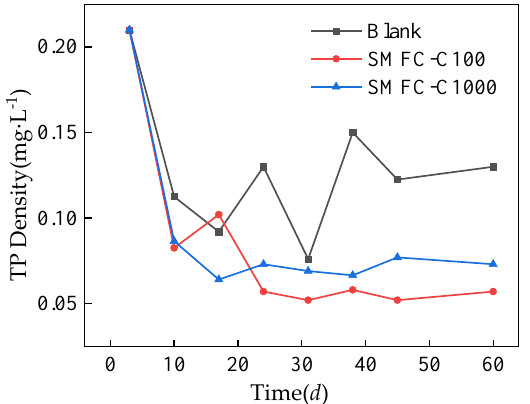
Figure 7. TP concentration curves.